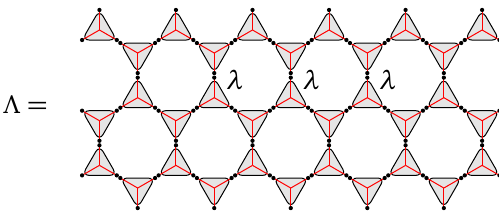
Figure 3: The hypergraph entanglement structure Λ of the RVB state. The triangles represent the λ tensor, and the entanglement structure Λ is obtained by tensoring 2 L copies of it and arranging the vertices according to the kagome 3